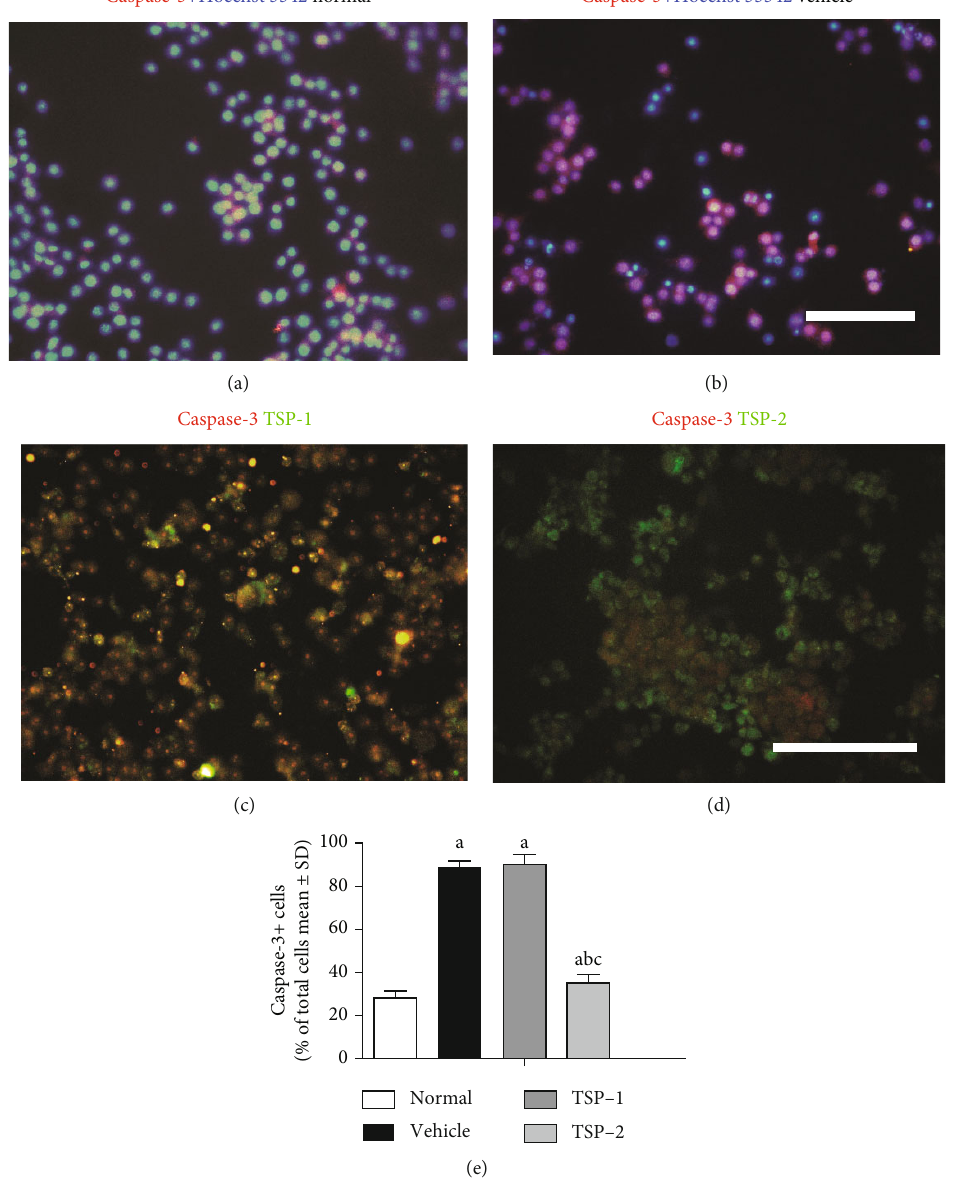
Figure 2: E ff ect of TSP-2 overexpression on LPS-induced apoptosis. MH-S murine alveolar macrophage cells were either untreated (normal and nontreatment) or treated with LPS (1 μ g/ml) for 24h following either empty vector (vehicle group), TSP-1 (TSP-1 group), or TSP-2 (TSP- 2 group) overexpression. Cells were stained with caspase-3 (red) antibody to assess apoptosis (a – d), respectively. Hoechst 33342 dye (blue) was used to stain the nucleus. Green stain represents TSP-1 and TSP-2 overexpression. The yellow color depicts overlay image of caspase- 3 and TSP expression in the same cell. (e) Bar graph representing overall quantitation and parallel comparison of caspase-3 staining among the four groups. The percentage of labeled cells/total cell numbers are shown as mean ± SD . P value of < 0.05 represents signi fi cant di ff erence. a P < 0 : 05 compared with normal control; b P < 0 : 05 compared with the vehicle group; c P < 0 : 05 compared with the TSP-1 transfected group ( n = 5 per